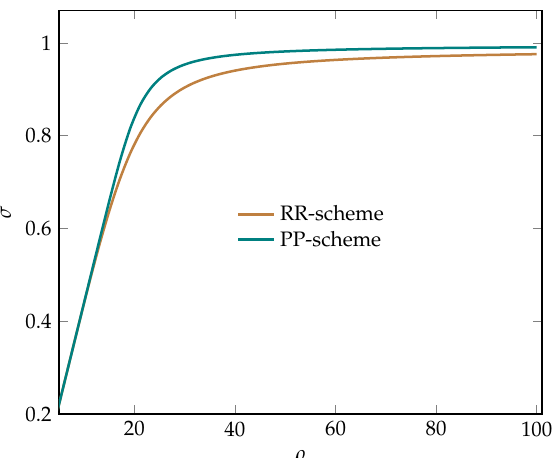
Figure 11. The average utilization of the total network capacities vs. the offered